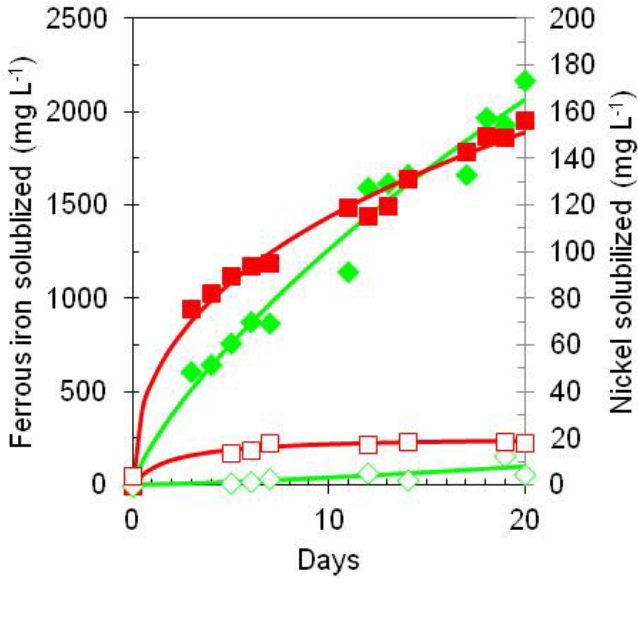
Figure 1. Changes in concentrations of soluble iron ( ■ , □ ) and nickel ( ♦ , ◊ ) in bioreactor cultures of At. ferrooxidans containing Ni laterite ore and elemental sulphur, incubated either under anoxic (solid symbols) or aerobic (open symbols)